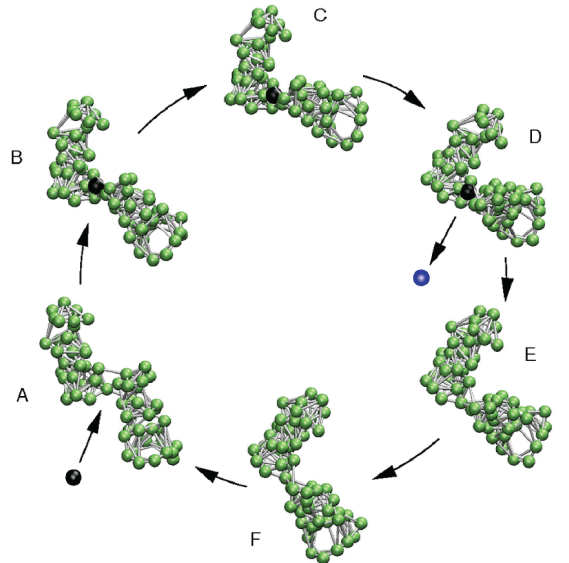
Figure 2. Model molecular machine. A single operation cycle is shown. In the open conformation (A), a substrate ligand bead can bind and trigger the soft hinge motion between the domains (B–D). In the conformation corresponding to the steady state of the network–ligand complex (D), the ligand becomes converted into the product, and after its release, motions which bring back the network to its initial free conformation take place (D–F and A). Figure taken from Reference [24] (slightly modified). The proposed machine mimics the principal operation mechanism of a real protein